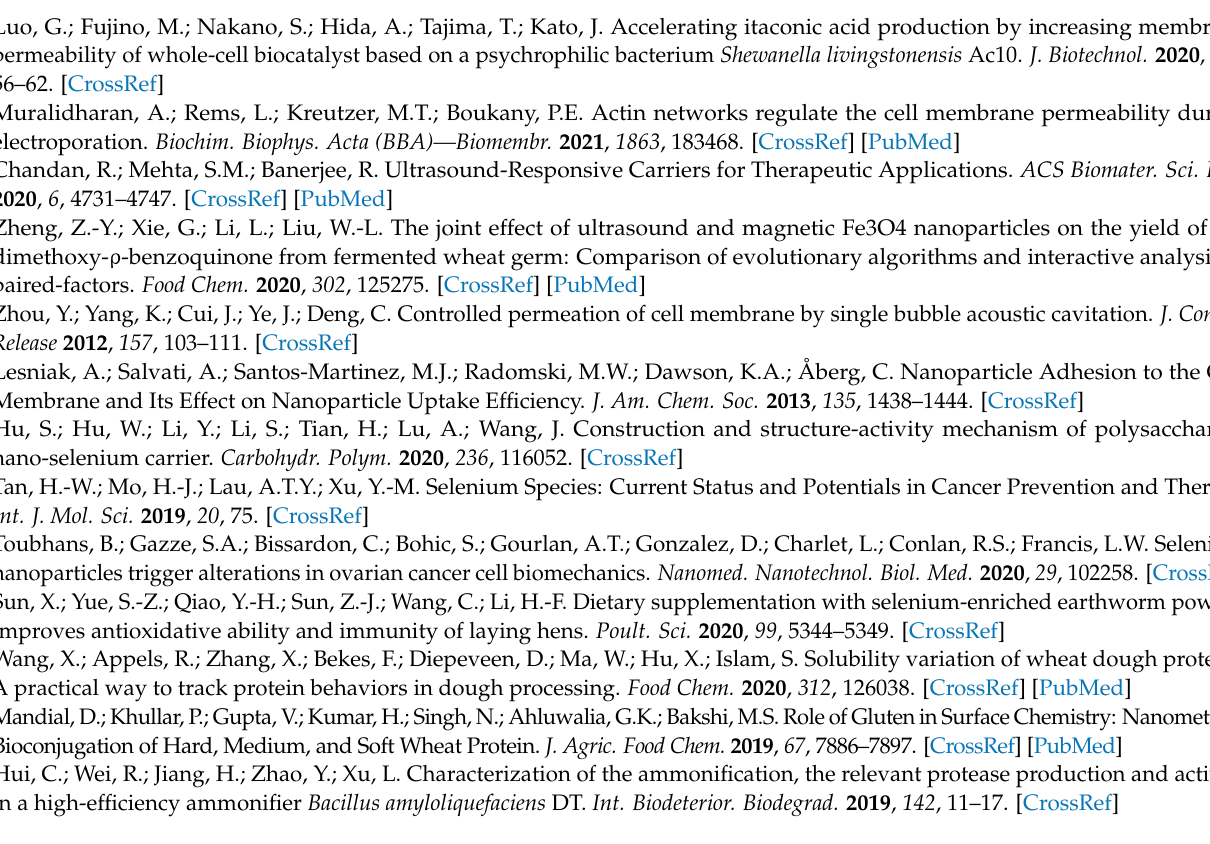
nano-Se, Figure S2: TEM images of the prepared nano-Se, Figure S3: Volcano plots showing the distribution of DEGs between U+nano-Se@PC0 and U+nano-Se@PC12, arranged by fold-change (x axis) and FDR-p values (y axis). DEGs are colored blue (down-regulation) and red (up-regulation), Figure S4: Volcano plots showing the distribution of DEGs between U+nano-Se@PC2 and U+nano- Se@PC12, arranged by fold-change (x axis) and FDR-p values (y axis). DEGs are colored blue (down-regulation) and red (up-regulation), Figure S5: KEGG pathway enrichment analysis of DEGs between U+nano-Se@PC2 and U+nano-Se@PC12, Figure S6: KEGG pathway enrichment analysis of DEGs between U+nano-Se@PC0 and U+nano-Se@PC12, Figure S7: GO classification of DEGs between PC2 and PC12 groups, Figure S8: GO classification of DEGs between PC0 and PC12